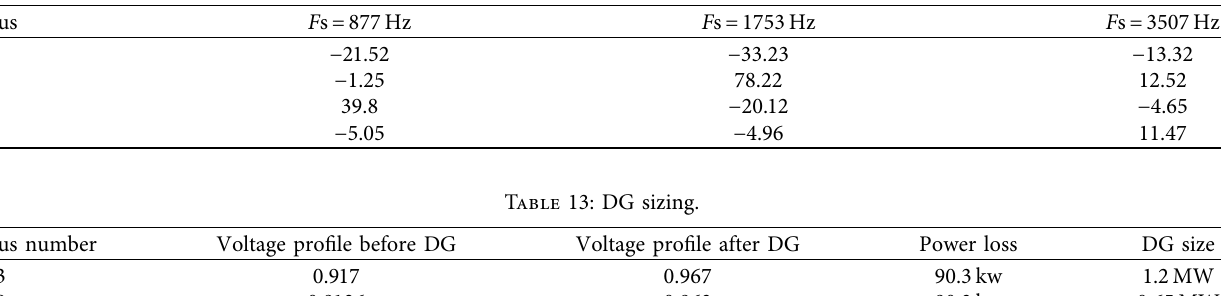
Table 12: Nonradial network bus power flow with DWT.